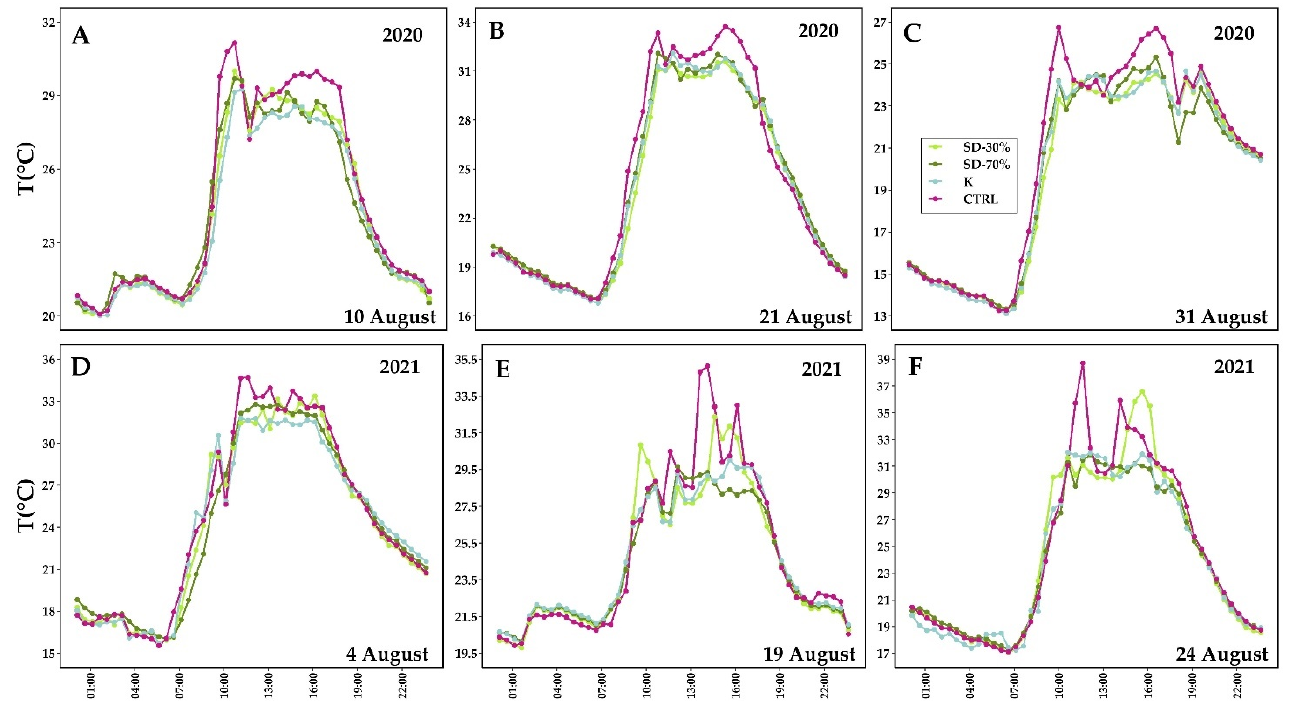
Figure 7. Berry temperatures (( A – C ) 2020; ( D – F ) 2021) of Vitis vinifera with four different canopy management: SD-30% (green artificial shading net at 30%; light green lines), SD-70% (green artificial shading net at 70%; dark green lines), K (kaolin; light blue lines), and CTRL (control; purple lines).